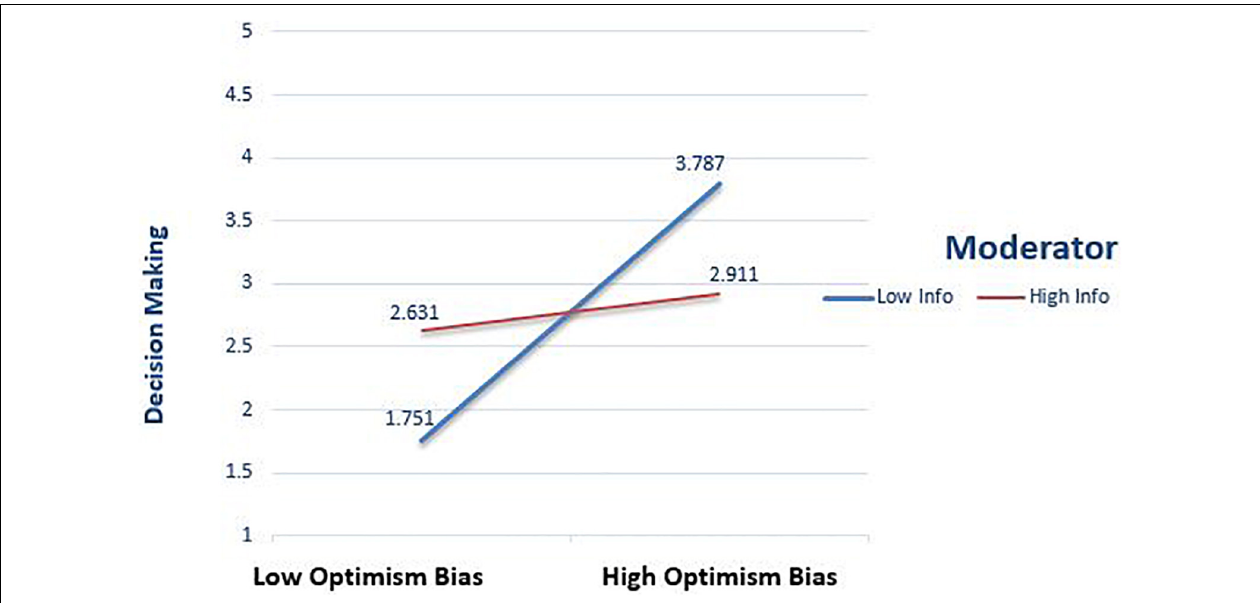
FIGURE 4 | Interaction effect between Optimism Bias and Decision